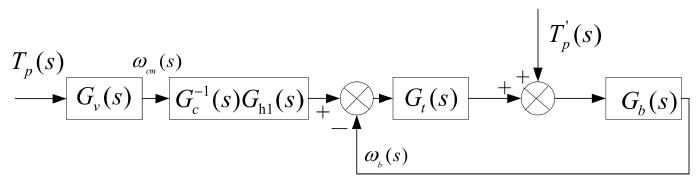
Figure 4. Simplified RLS based on a forward model.